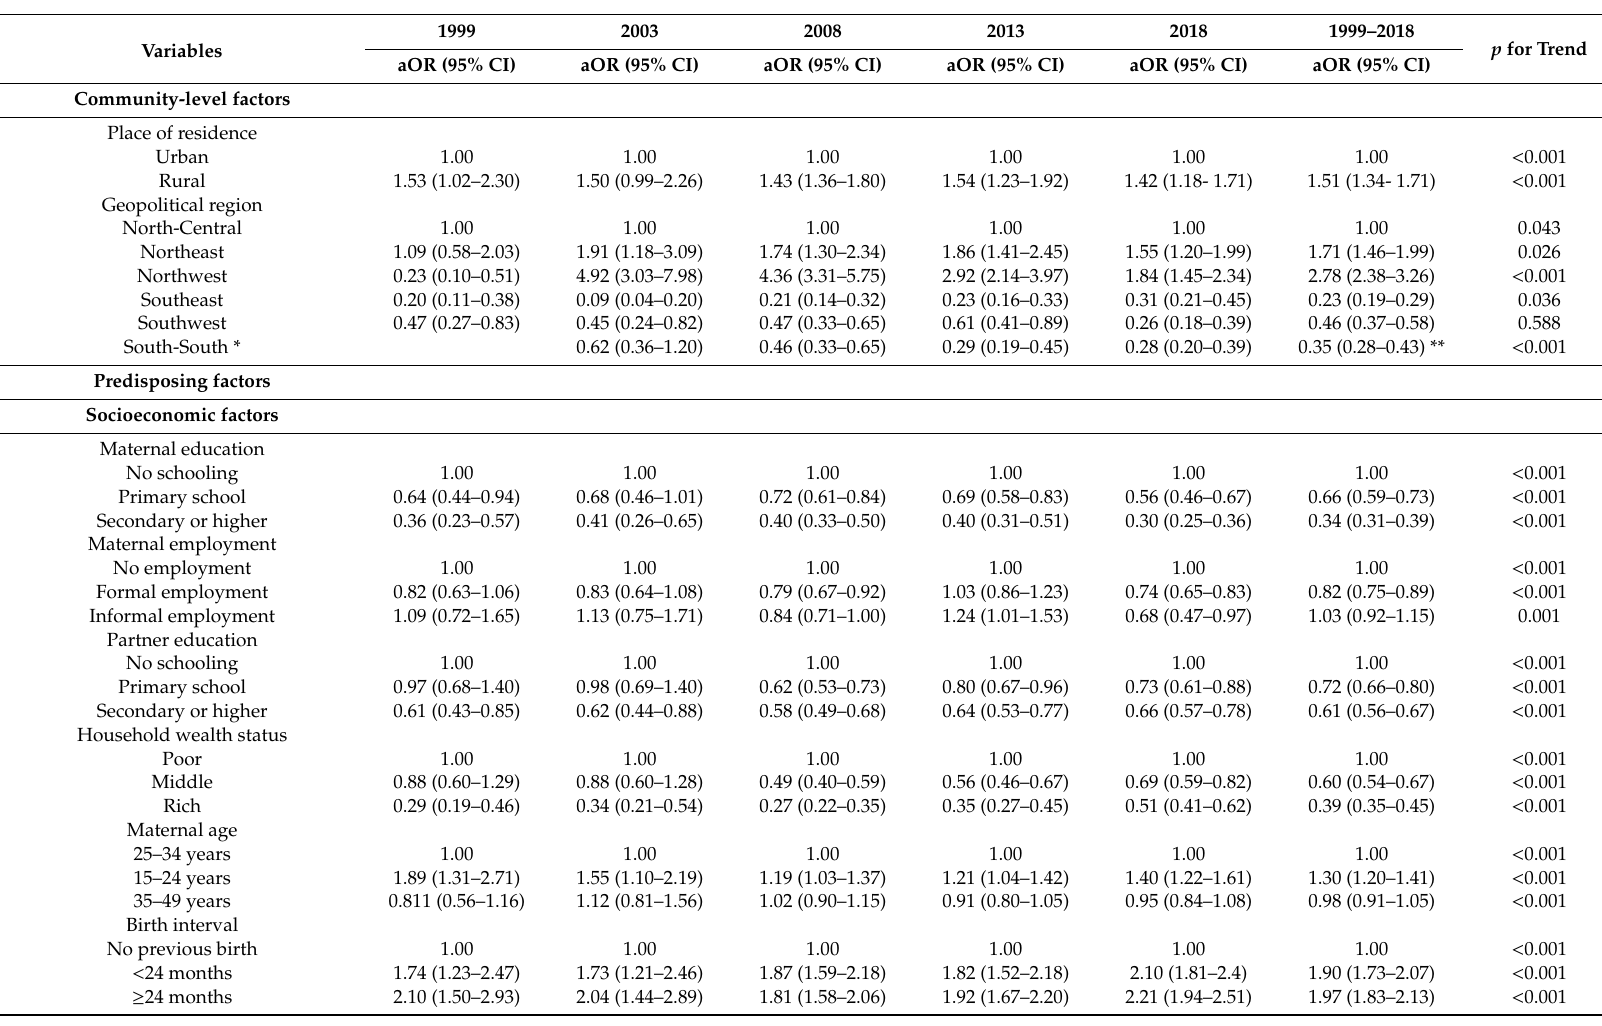
Table 4. Determinants of other-unskilled-birth-attendant-assisted delivery in Nigeria,